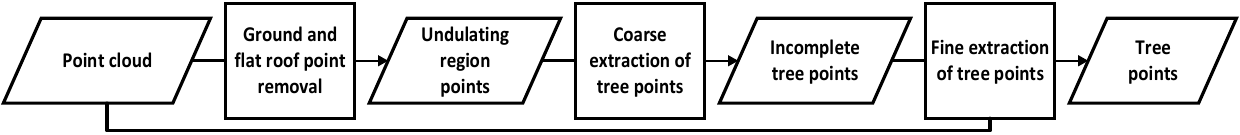
Figure 1. Flowchart of tree points extraction method.